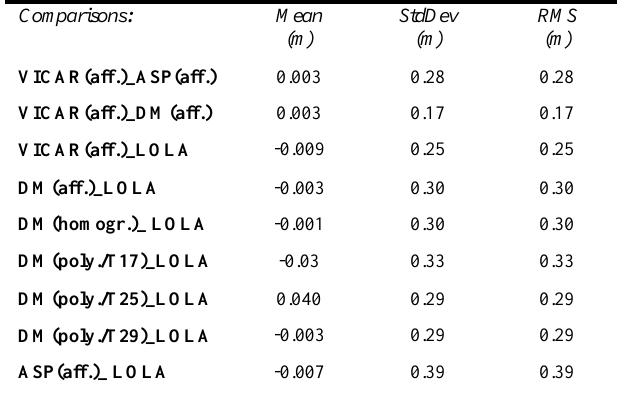
Table 2: Comparisons with LOLA data using different shape function and different software in the Lunokhod1 case